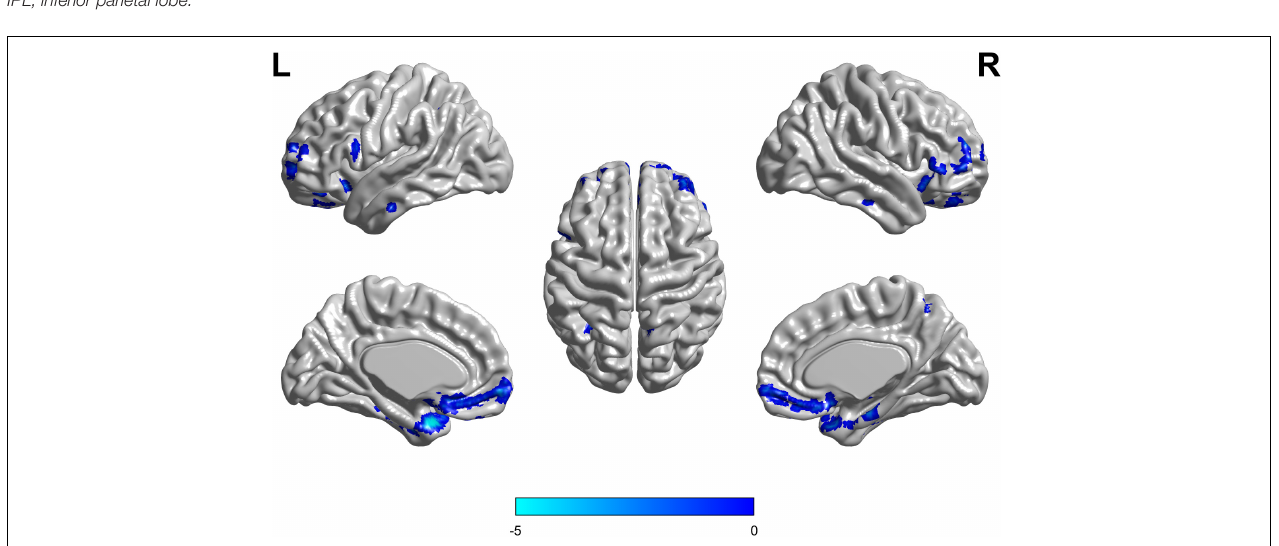
FIGURE 4 | The APOE ε 2/ ε 3 carriers groups had a slight decreased standard uptake value ratio (SUVR) of FDG-PET in the Frontal Lobe compared to the APOE ε 3/ ε 3 homozygote groups. The statistical threshold was set at p < 0.01 with a cluster-level of p < 0.05 (two-tailed, GRF corrected).